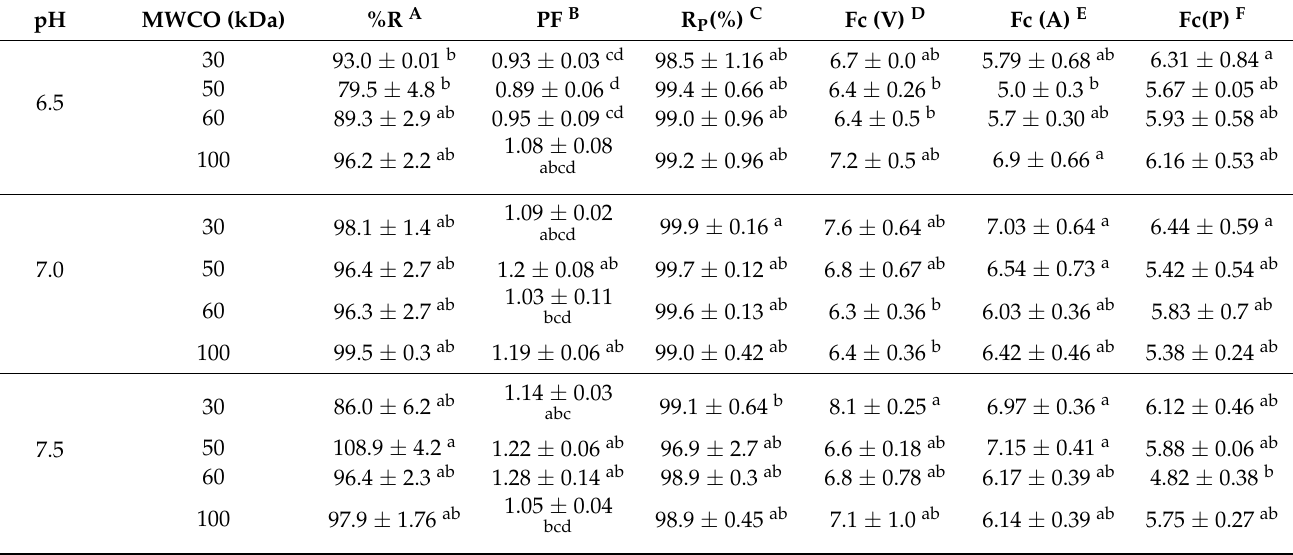
Table 1. Effects of membrane molecular weight cut-offs on β -galactosidase concentrations at pH 6.5, 7.0, and